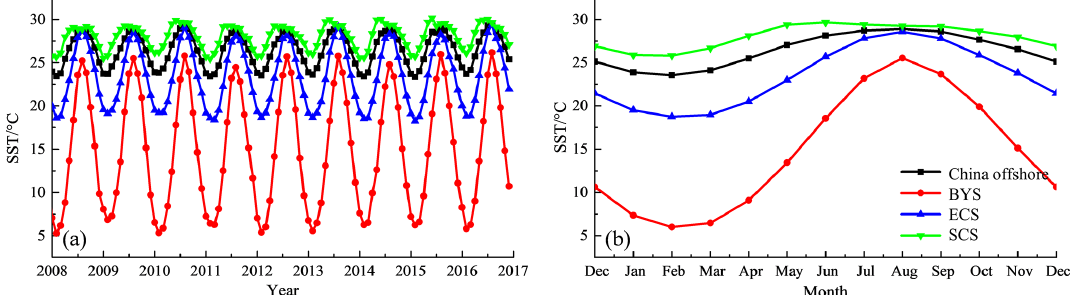
Figure 12. Long-term monthly mean SST of the marginal seas of China during 2008–2017: (a) yearly; (b) monthly. Black line: China offshore; red line: Bohai Sea and Yellow Sea (BYS); blue line: East China Sea (ECS); green line: South China Sea